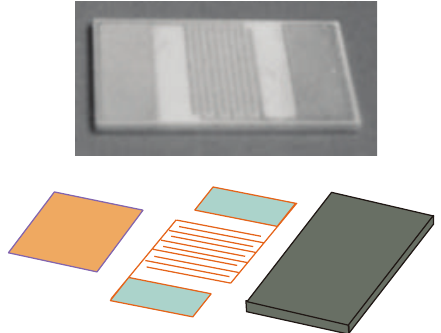
Figure 1: Structure chart of the fabricated planar sensor.